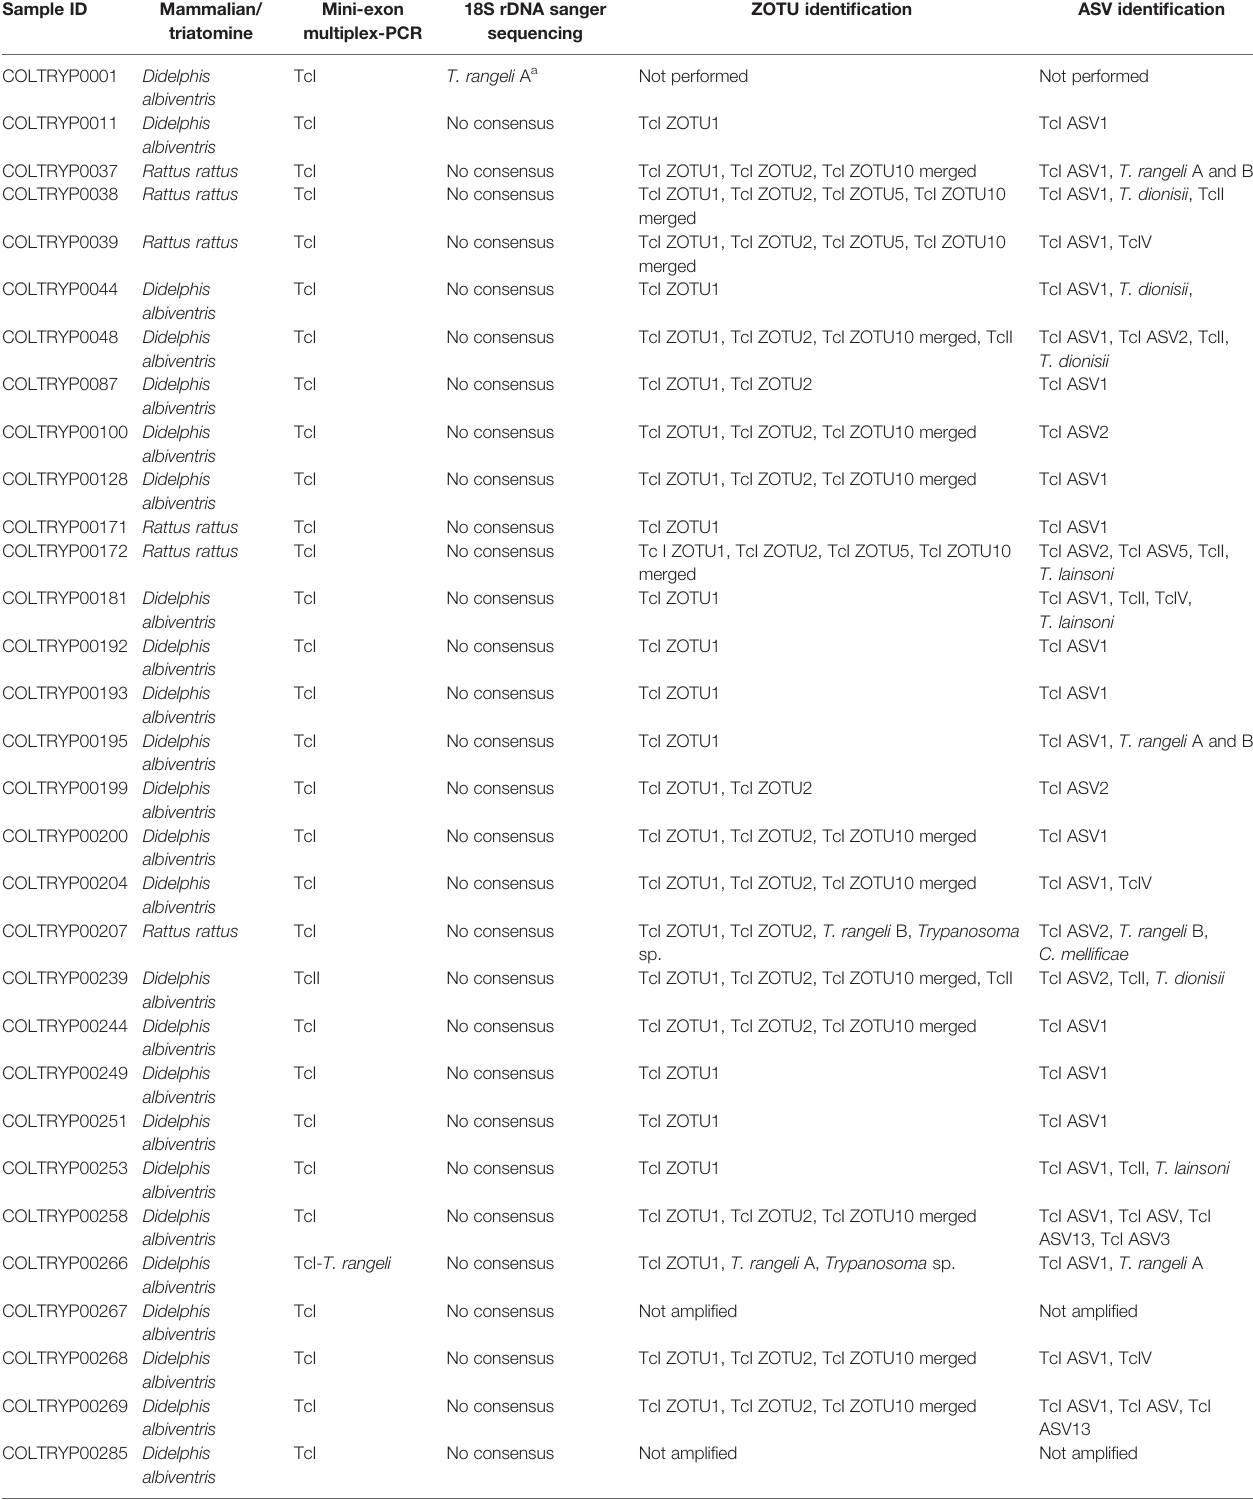
TABLE 2 | Trypanosomatid molecular characterization of Rattus rattus , Didelphis albiventris , and triatomines by mini-exon multiplex-PCR, 18S rDNA Sanger sequencing, and next-generation sequencing. Sample